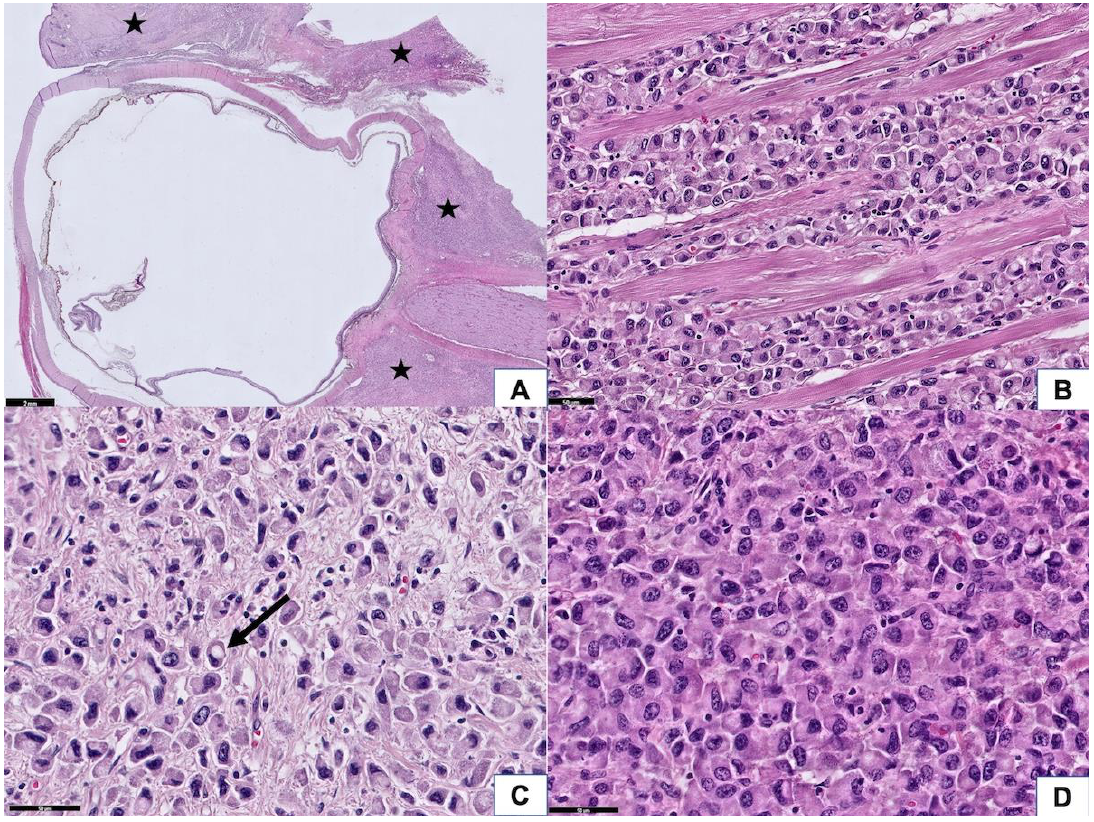
Figure 2. Histopathological features of the tumor. ( A ) At scanning power, the tumor was diffusely infiltrated in the eyelid, extraocular muscle, and retrobulbar soft tissue (asterisk). The optic nerve was spared (50× magnification). ( B ) Tumor cells diffusely infiltrated in the extraocular skeletal muscle, manifesting a destructive growth pattern and causing a limitation of eye movement (200× magnification). ( C ) A few tumor cells reveal a signet ring cell feature (arrow) (400× magnification). ( D ) Some of the tumor cells have enlarged nuclei, exhibiting a histiocytoid appearance (400× magnification).